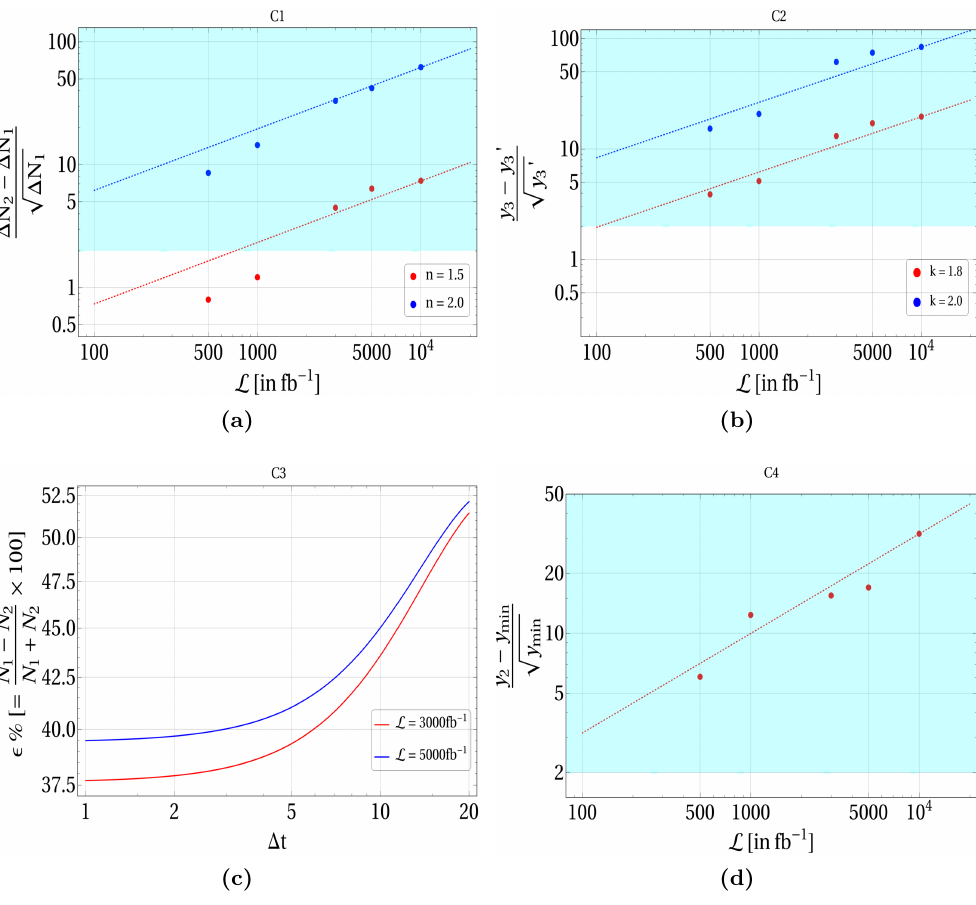
Figure 21. Same as figure 19 but for